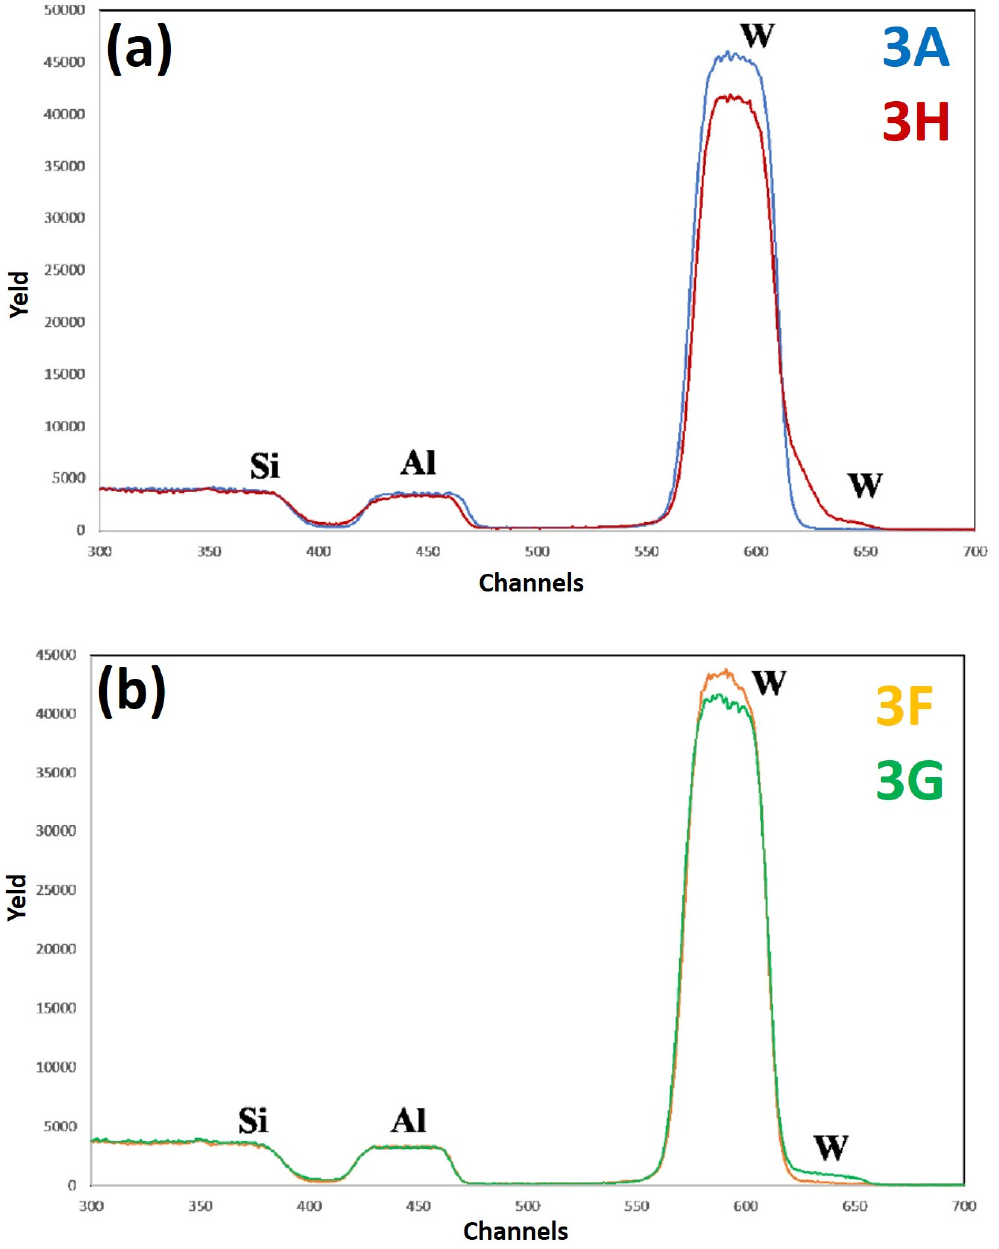
Figure 12 . RBS spectra of the samples: ( a ) 3A (Si/W/Al)—blue curve, and 3H (Si/W/Al + 500 °C 15 min)—red curve; ( b ) 3F (Si/W/Al + 400 °C 15 min)—yellow curve, 3G (Si/W/Al + 450 °C 15 min)—green curve. The curves are reported in different plots to easiliy identify characteristic features and differences.